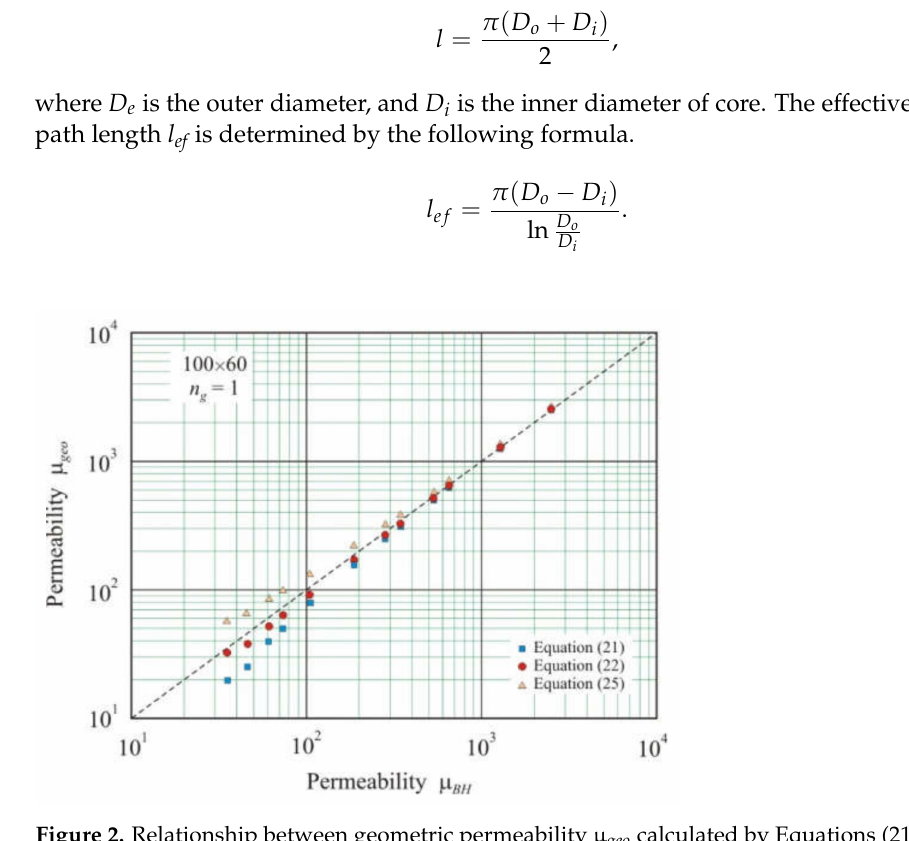
Figure 2. Relationship between geometric permeability µ geo calculated by Equations (21), (22), and (25) and effective permeability µ BH obtained using FEMM simulation in soft magnetic annuluses 100 × 60 mm with one air gap of length l g 1 from 1 × 10 − 4 to 1.28 × 10 − 2 m. The dashed line corresponds to equation µ geo = µ BH